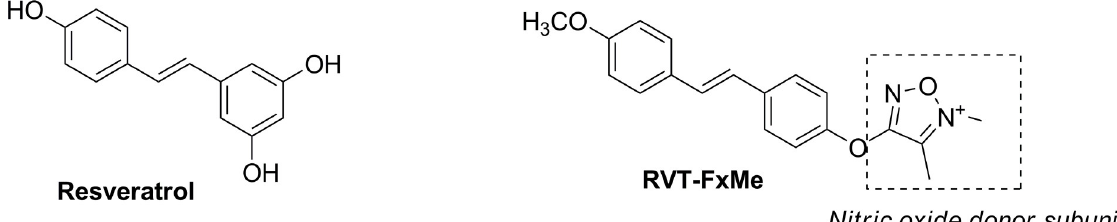
Fig 1. Chemical structures of resveratrol and